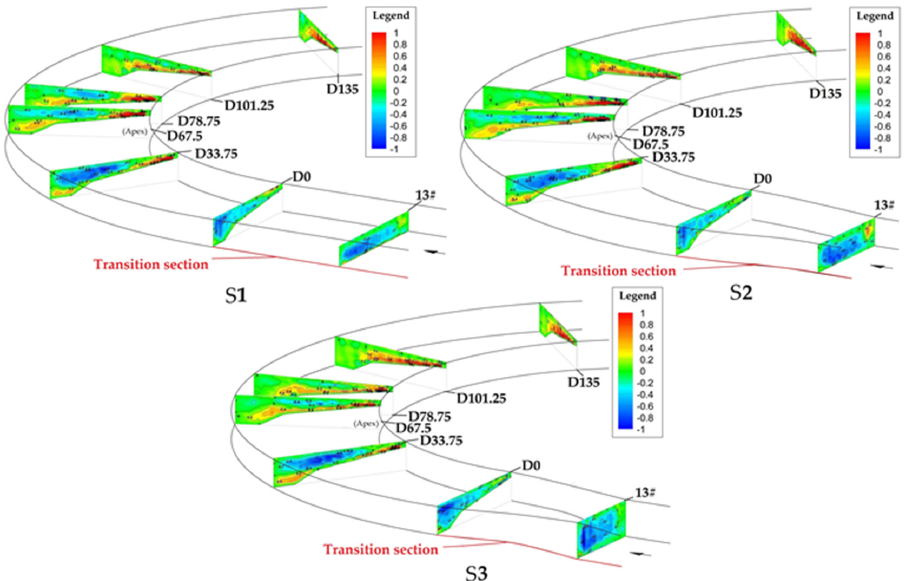
Figure 9. Distribution of the circulation intensity of a typical cross-section along the back bend at Q3 and different scenarios.